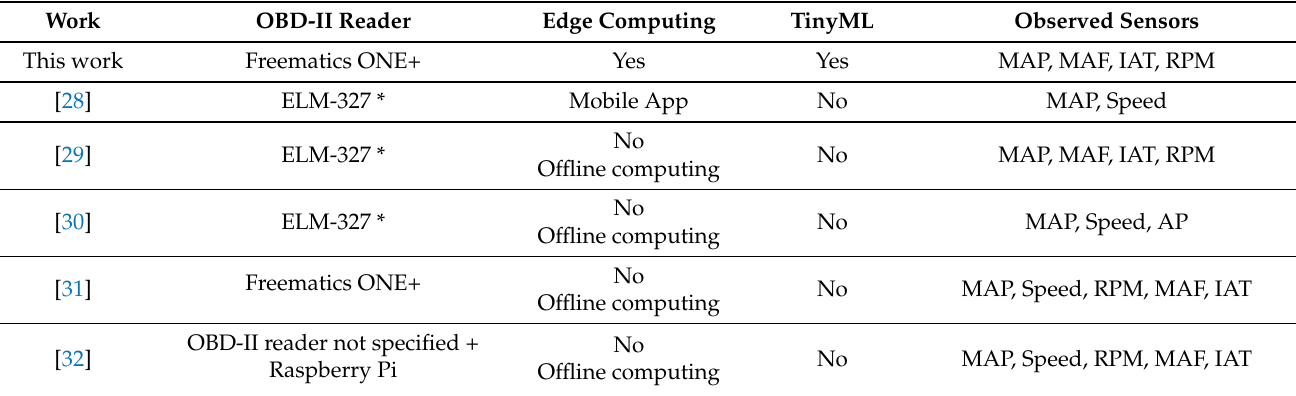
Table 1. Summary of recent related